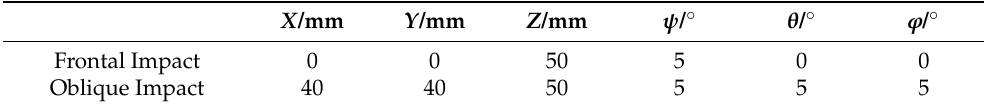
Table 1. Initial condition of attitudes.